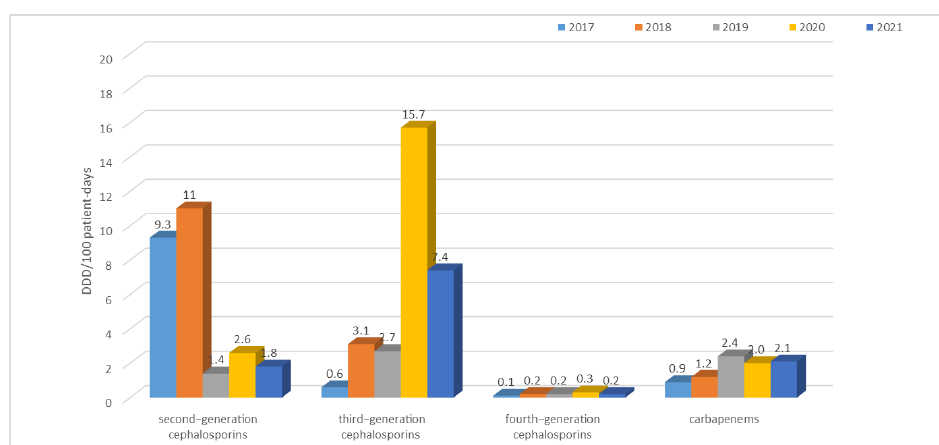
Figure 25. Consumption of second-generation cephalosporins (cefuroxime), third-generation ceph- alosporins (cefotaxime, ceftriaxone, ceftazidime), fourth-generation cephalosporins (cefepime), and carbapenems (imipenem, meropenem) in 2017–2021.